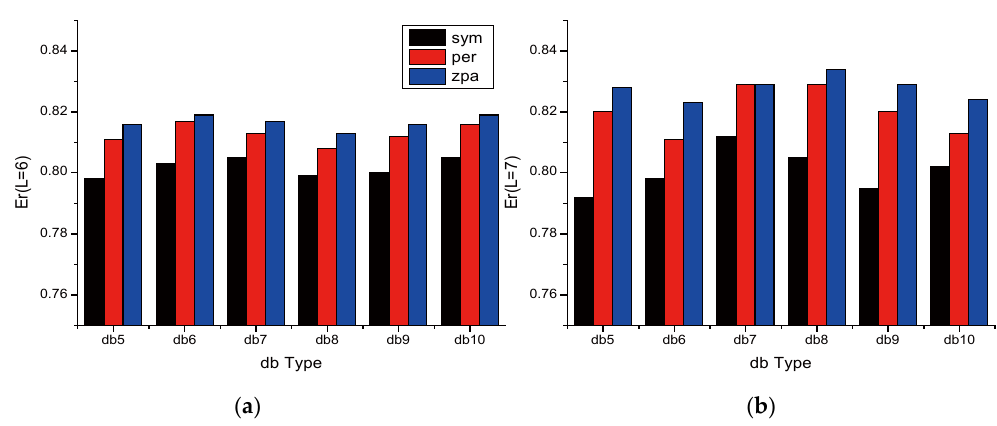
Figure 4. Er values of monthly mean streamflow series with different extension mode in six and seven levels (sym: symmetrization extension; per: periodic extension; zpa: zero-padding extension). ( a ) L=6; ( b ) L=7.